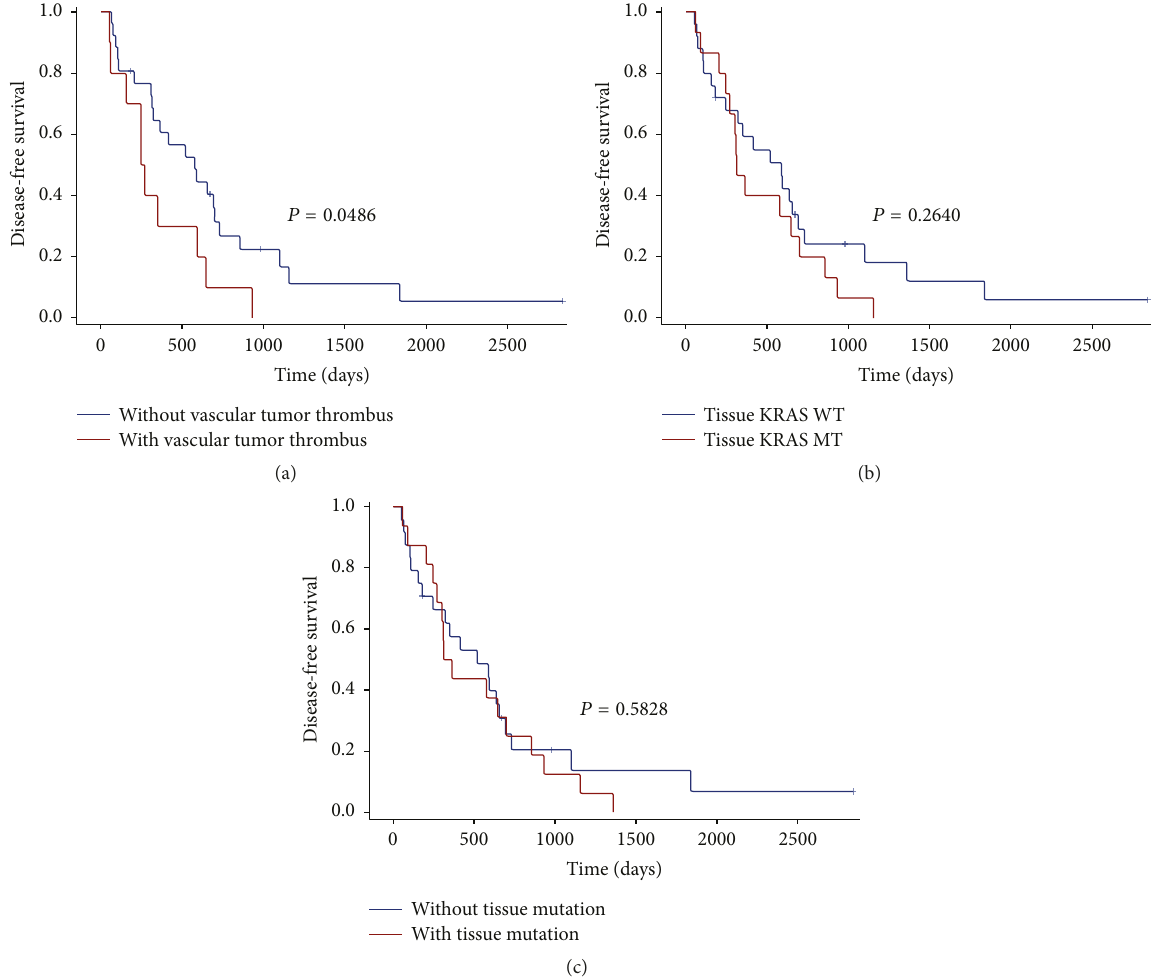
Figure 2: Kaplan-Meier plots of patients for disease-free survival (DFS) grouped by vascular tumor thrombus, KRAS mutation status, and RAS/BRAF mutation status. The DFS was significantly worse in patients with vascular tumor thrombus, with a median DFS of 259 days versus 578 days for nonvascular tumor thrombus patients ( 𝑃 = 0.0486 ) (a). There was no significant difference in DFS between KRAS mutant (MT) and wild type (WT) patients (median DFS 313 days versus 590 days, 𝑃 = 0.2640 ) (b) or between RAS/BRAF mutant patients and wild type patients (median DFS 339 days versus 519 days, 𝑃 = 0.5828 )